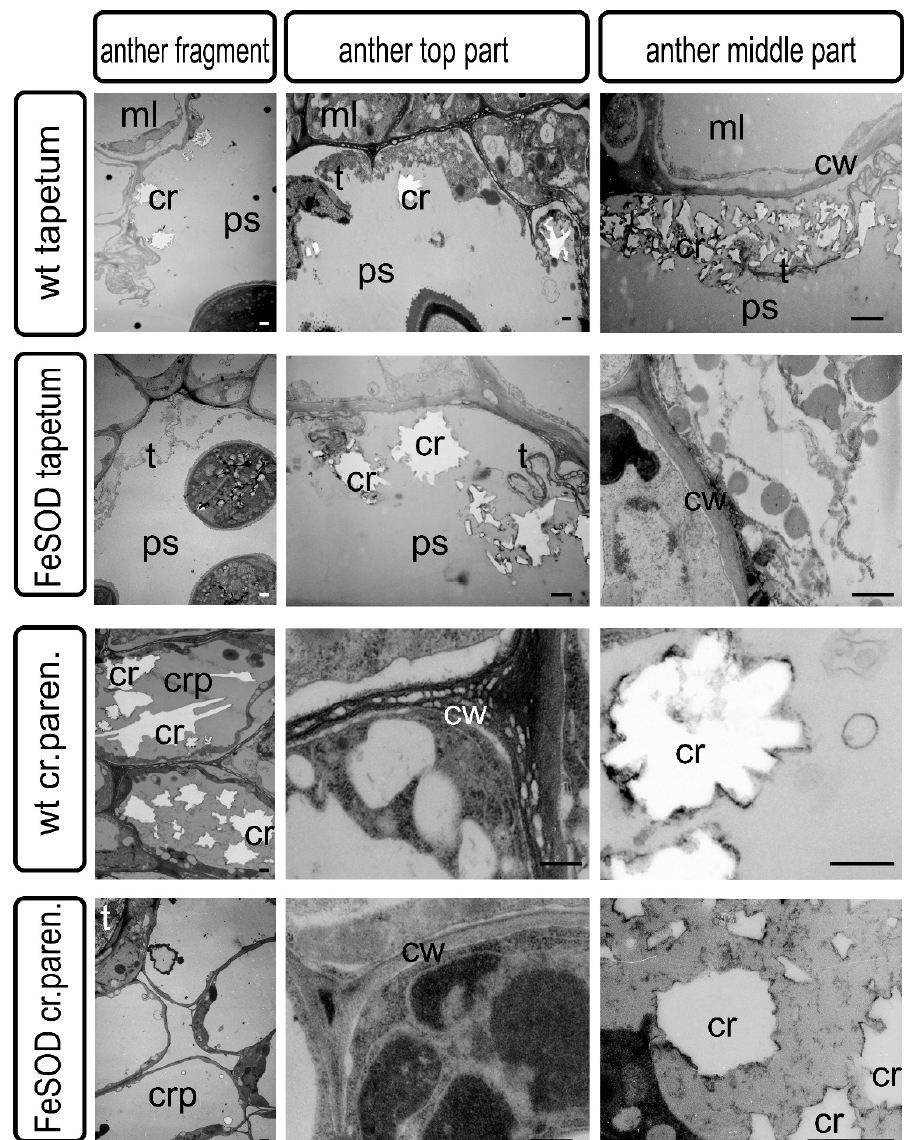
Figure 4. Transmission electron microscopy of cross sections of the anther tissue. The top two rows represent tapetum cells in the anthers of WT and transgenic tomato plants. The bottom two rows represent crystal-bearing cells in the anthers of WT and transgenic tomato plants. Ps—pollen sac; cr—crystal of calcium oxalate; cw—cell wall; crp—crystal-bearing parenchymatous cell; t—tapetum; ml—middle layer cell. Bar 2 μ m.